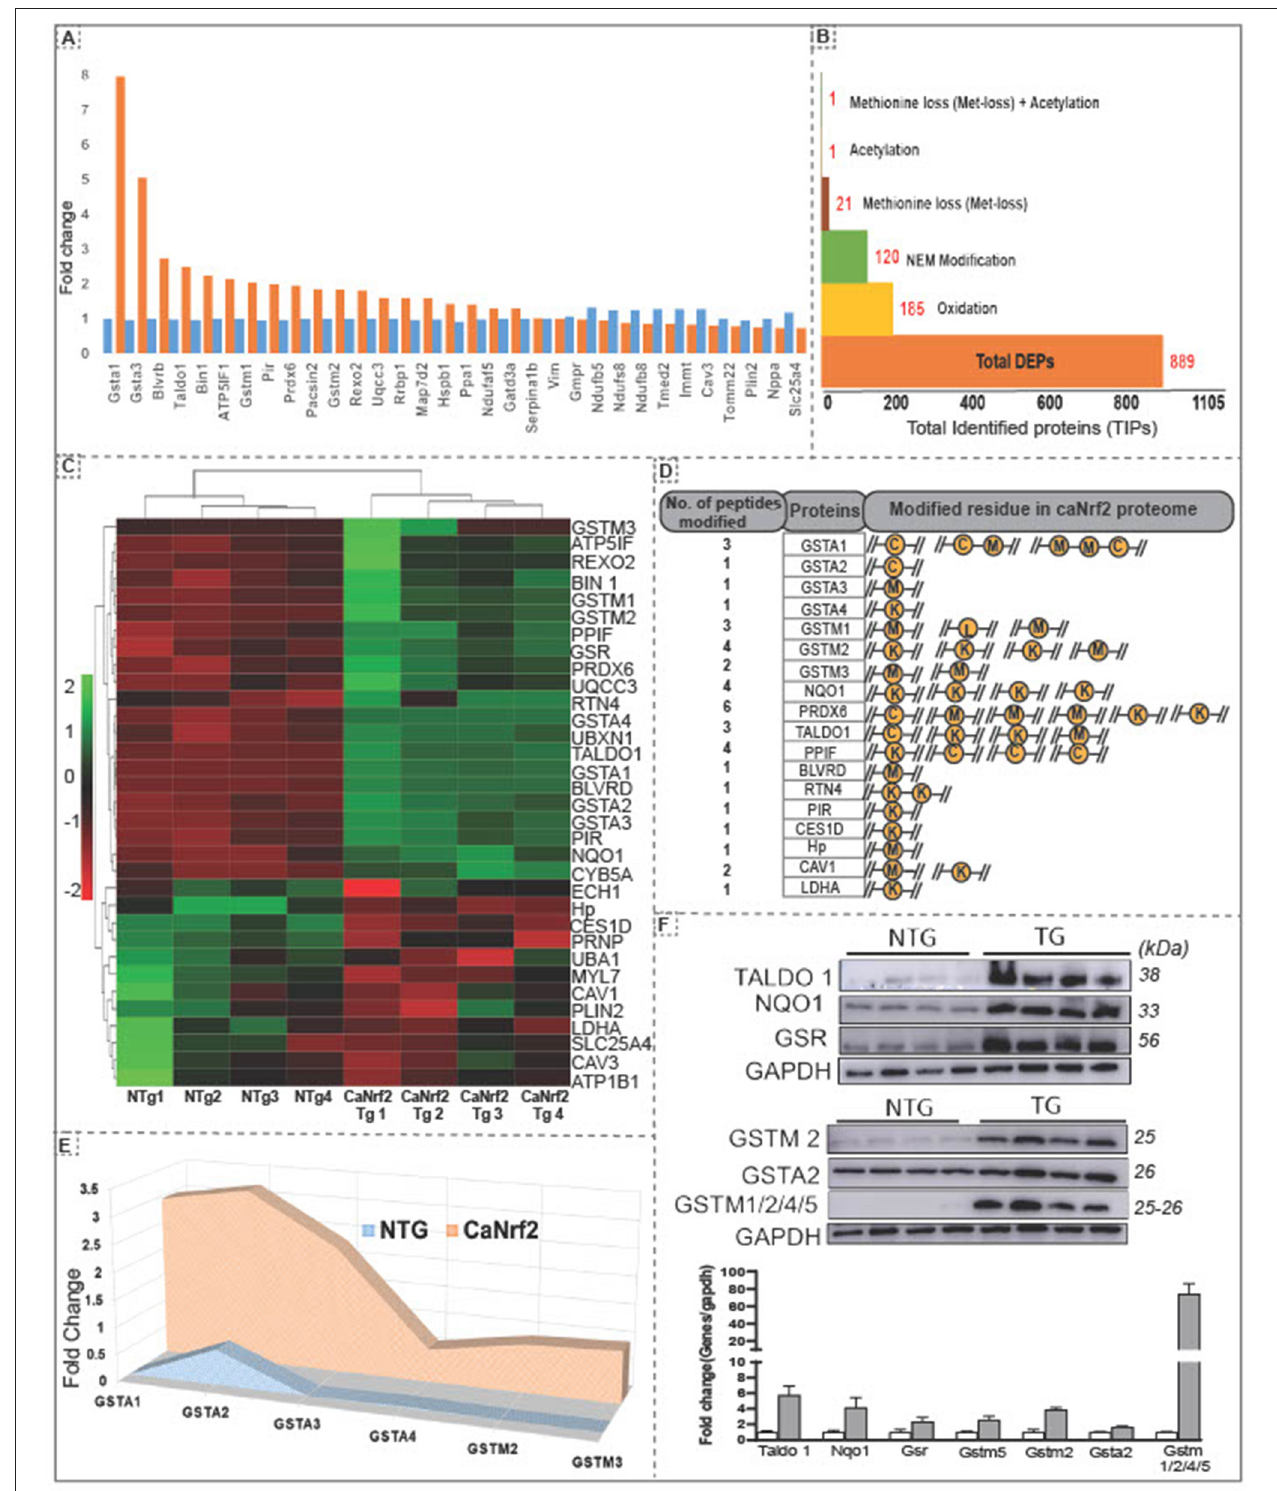
FIGURE 2 | Hierarchical clustering of differentially expressed proteins and amino acid modifications in proteins in the RS hearts. (A) Unsupervised clustering of total identified proteins showed 32 DEPs at 2 fold change with Gsta1, Gsta2, Blvrd, Taldo1, Bin1, Atp5lf1, gstm1,Pir and Prdx6 as the top upregulated proteins in CaNrf2 hearts. (B) Spectrum view by proteome scaffold software identified different types of modification in differentially expressed proteins (889) with 185 proteins having oxidation,120 with NEM modification, 21 with loss of methionine peptide, 1 with acetylation, 1 with acetylation and 1 peptide with both loss of methylation